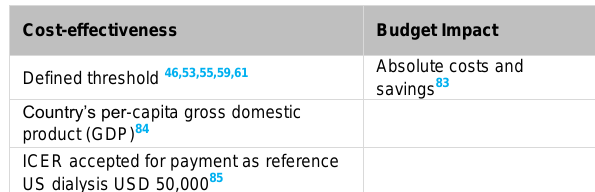
Table 4: Willingness to pay assessment key figures.